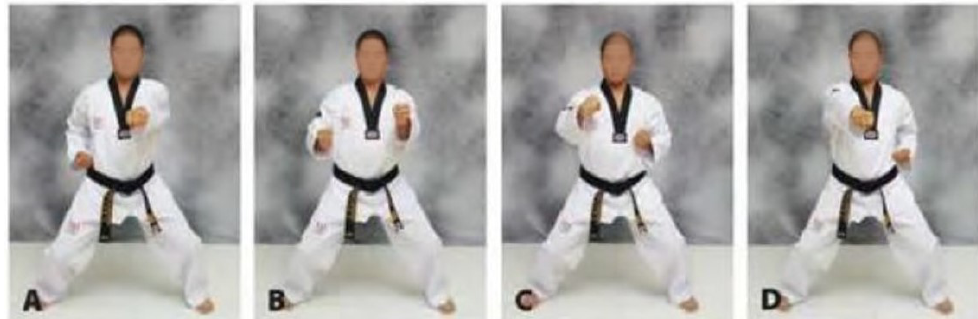
Figure 1. Taekwondo straight punch in a horse riding stance, ( A ) Straight punch with left hand in horse stance, ( B ) Rotating left hand to vertical position, ( C ) Retracting left hand and launching straight punch with right hand simultaneously, ( D ) Fully extended straight punch with right hand [39].